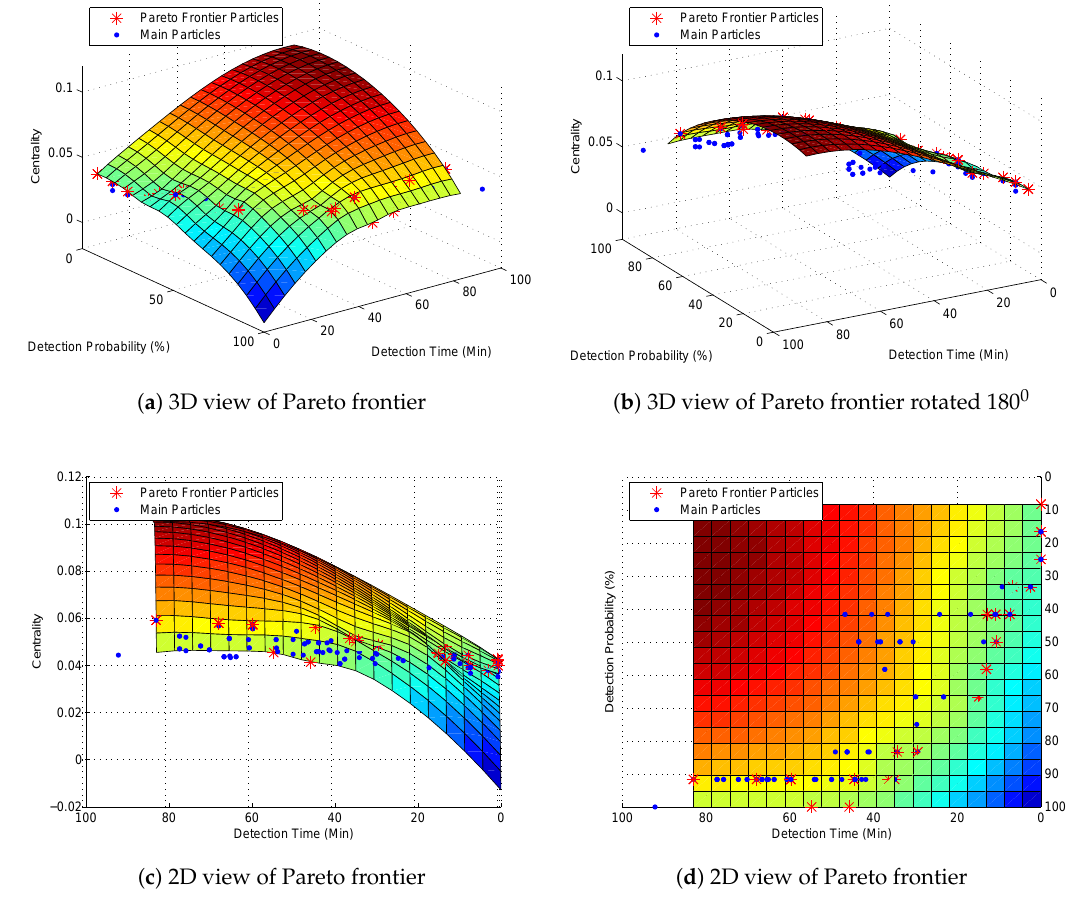
Figure 6. Pareto frontier with three optimization